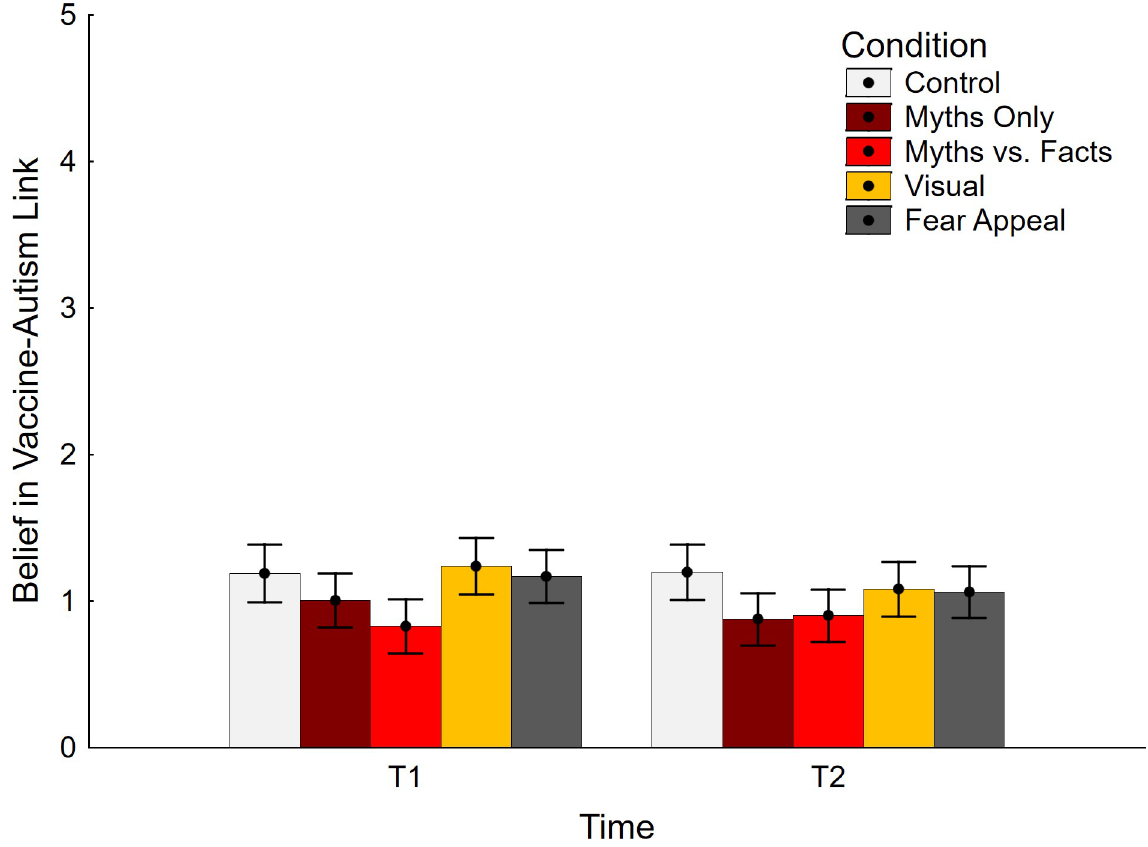
Fig 2. Belief in vaccine-autism link across conditions. Error bars show 95% confidence